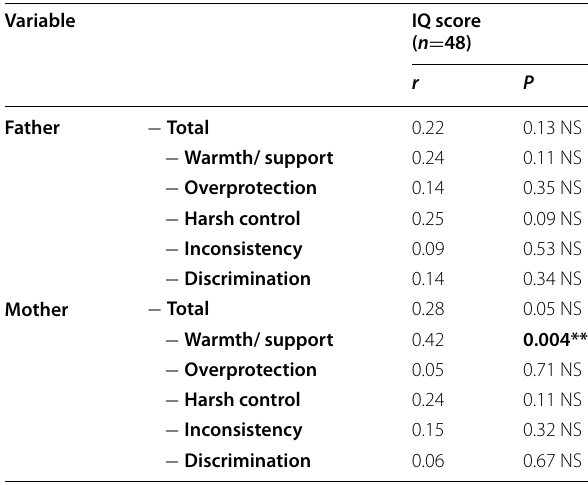
Table 6 Correlation between IQ and parenting among the studied